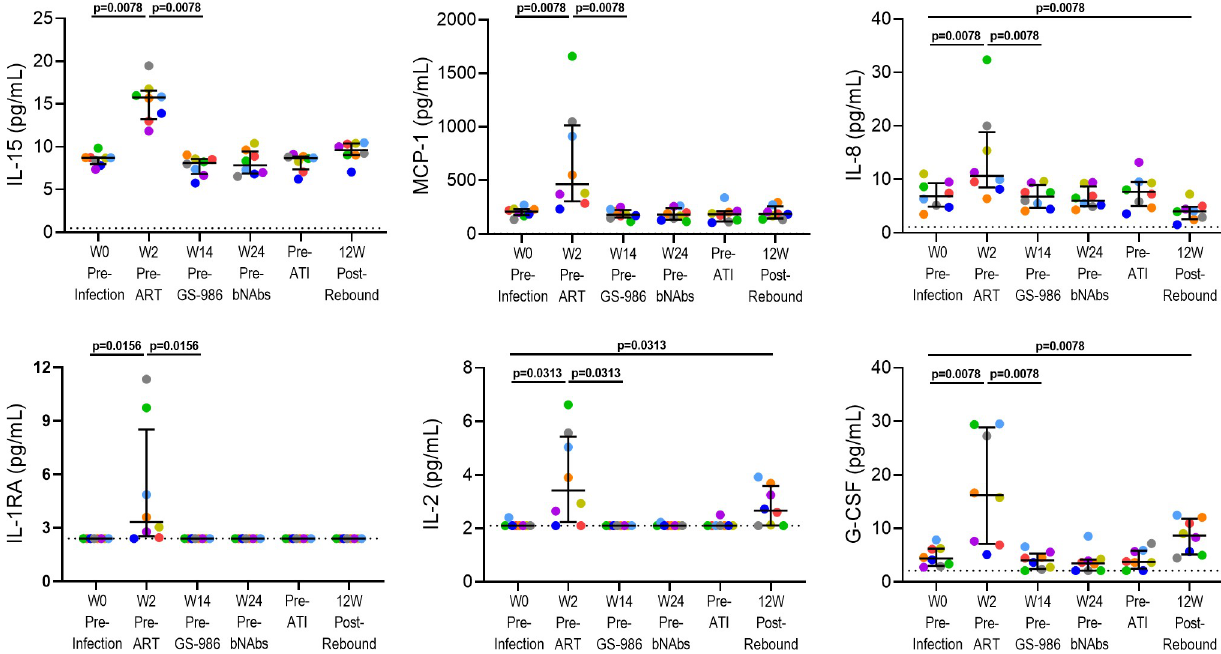
Fig 8. No evidence of persistent immune activation in the CSF associated with GS-986 or bnAbs. Biomarkers of immune activation and inflammation in the CSF were measured using multiplex assays. Cytokines that were increased after SHIV infection are shown. Data from animals in the active arm are displayed in color which each color corresponding to individual animals identified in Fig 4A. Lines and error bars represent median and interquartile range. Dotted lines represent limit of detection for respective markers measured.